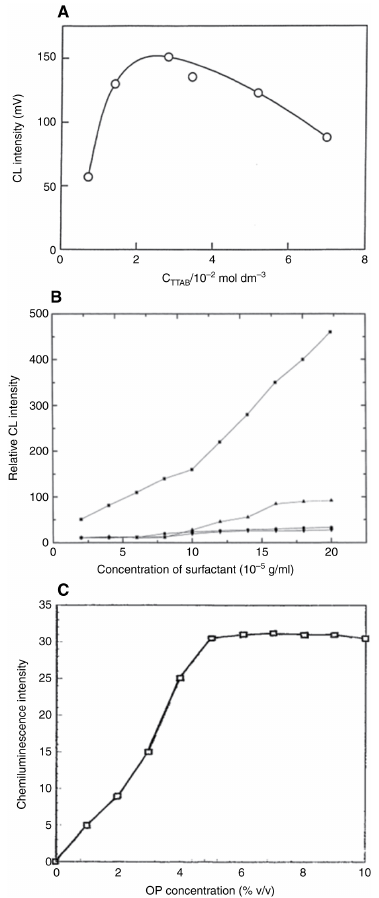
Figure 7: Effect of surfactant conentration on micelle-induced CL enhancement. Redrawn with permission from Saitoh et al. (1998), Li, Feng, and Lu (1998), and Sanfeliu Alonso, Lahuerta Zamora, and Martínez Calatayud